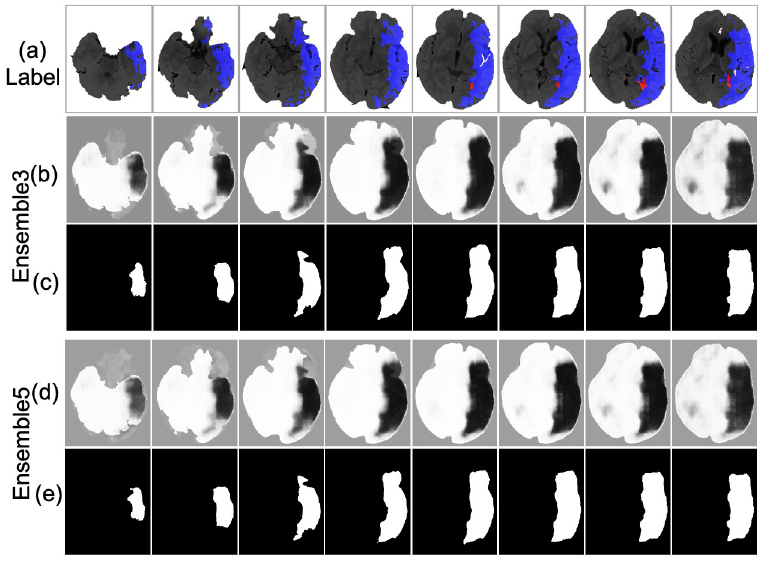
Fig 14. Lesion detection (a) CTp, (b), (d) Ensemble3 and Ensemble5 without postproceessing, (c), (e) Ensemble3 and Ensemble5 with postprocessing.